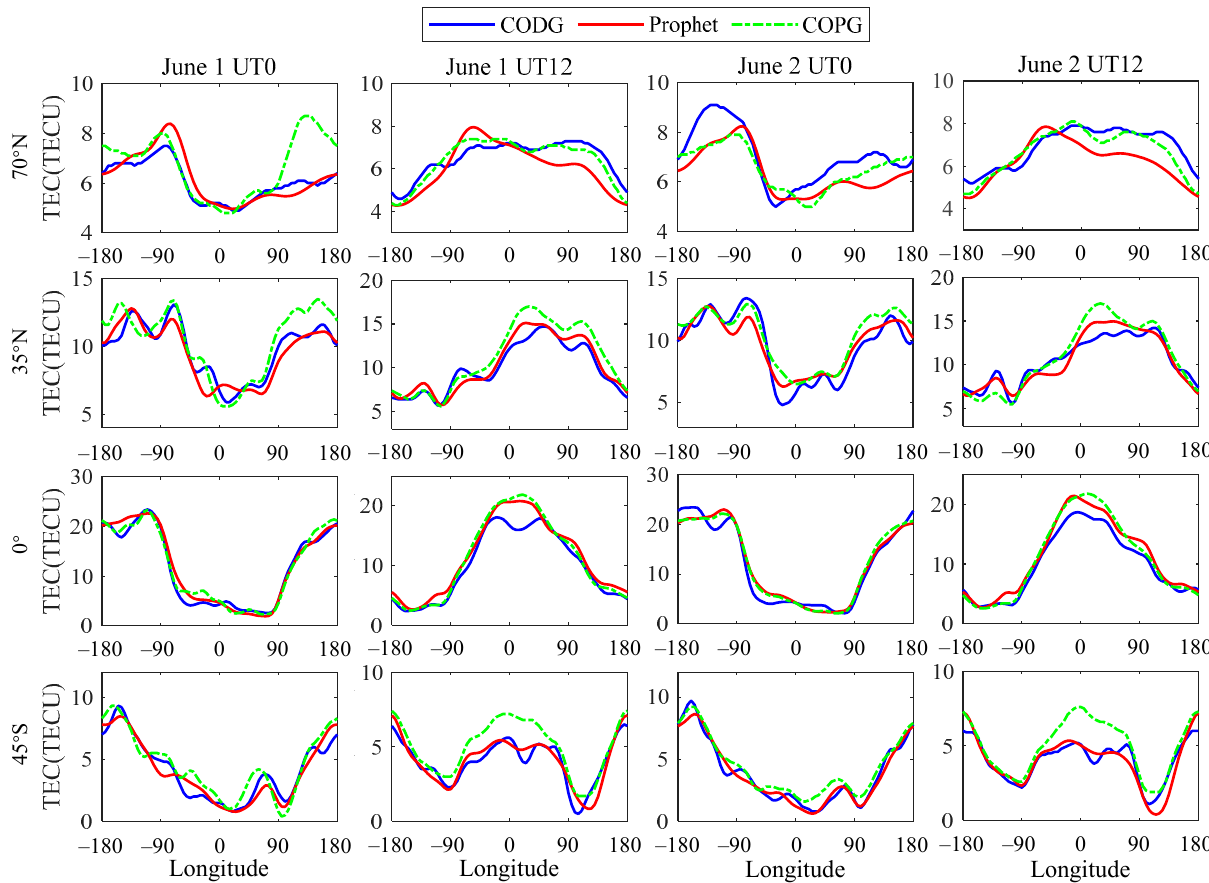
Figure 5. Forecasted residual distributions in a low-solar-activity year. Blue represents the Prophet model, and orange represents the COPG value.